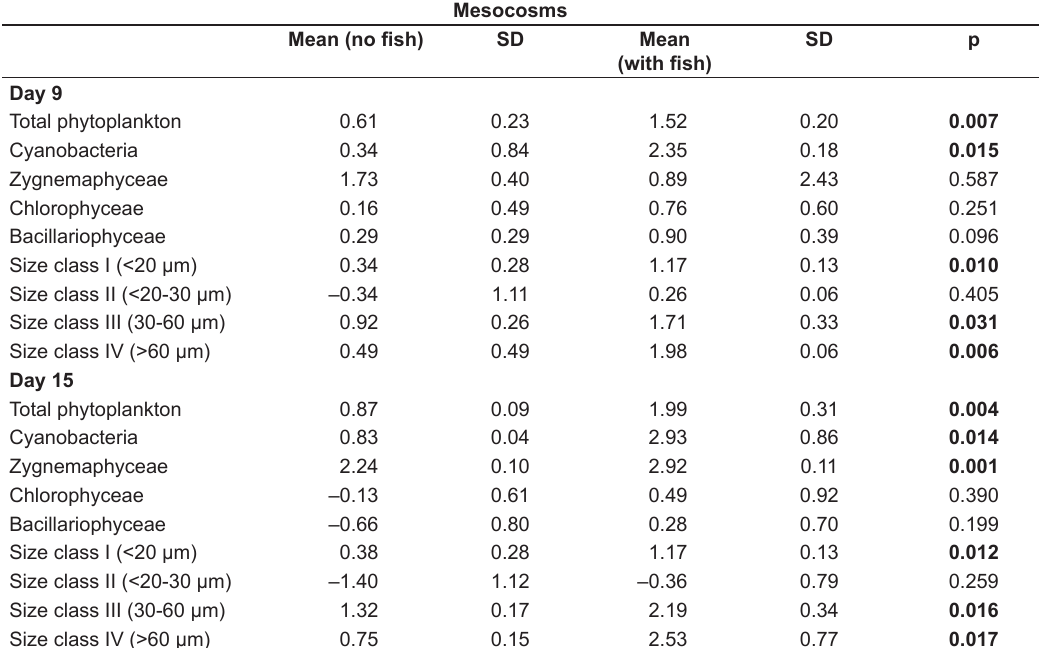
Table 2. Mean and standard deviation (SD) of the net changes in phytoplankton biomass of the major groups and size classes in the mesocosms, on days 9 and 15 of the experiment, and the t test results for differences of net changes between the treatment A (fish+) and the treatment B (fish–) ( p <0.05). Significant values are in